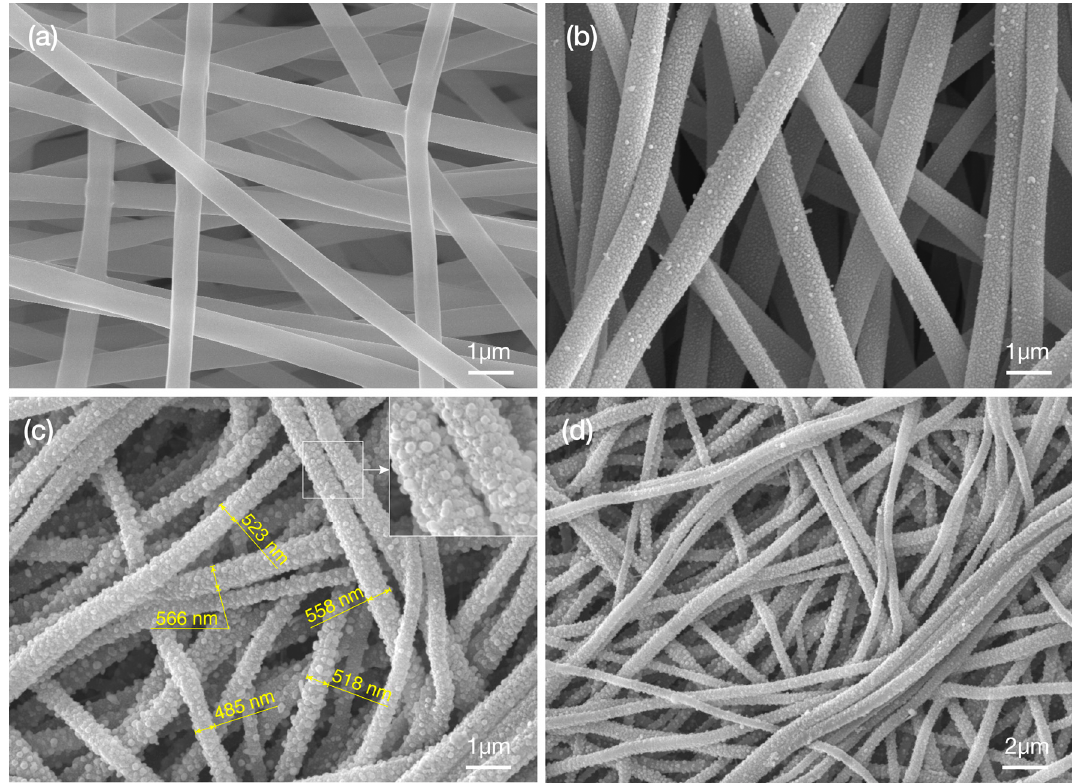
Figure 5. SEM images of ( a ) PAA/PEI nanofibers ( b ) silver-coated nanofibers (NFs), and palladium-coated NFs ( c , d ).